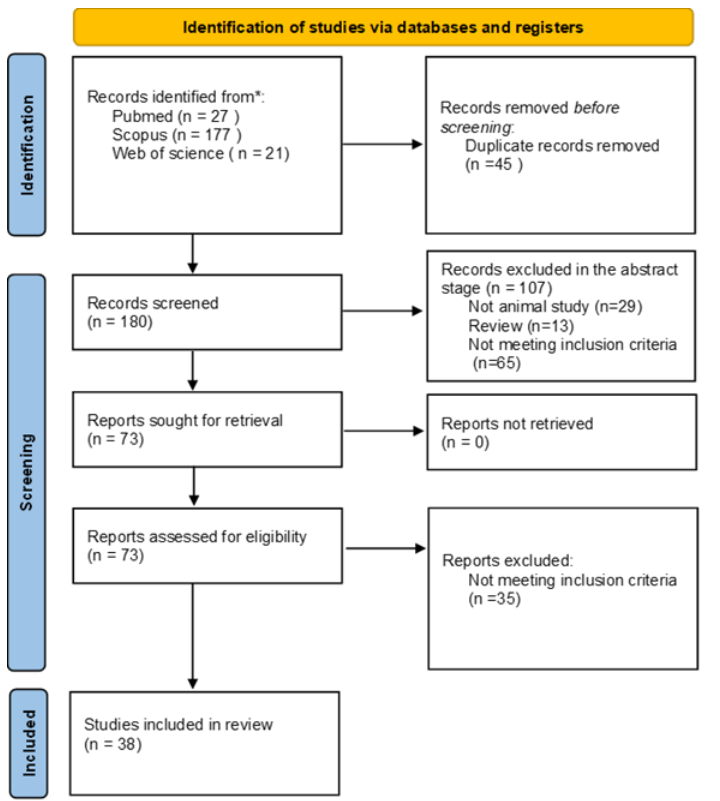
Figure 1. Flow diagram of study selection process. The flow diagram is divided into four phases: identification, screening, eligibility, and inclusion. * refers to scientific databases.